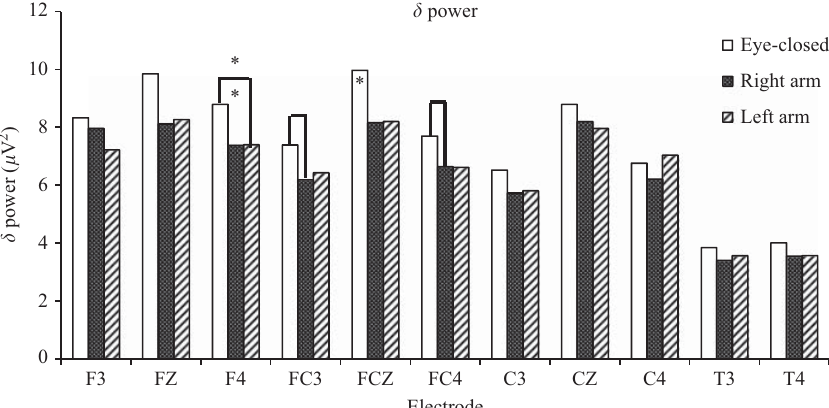
Figure 2. The δ power over frontal (F), fronto- central (FC), central (C) and temporal (T) electrodes comparing between eye-closed and arm massage